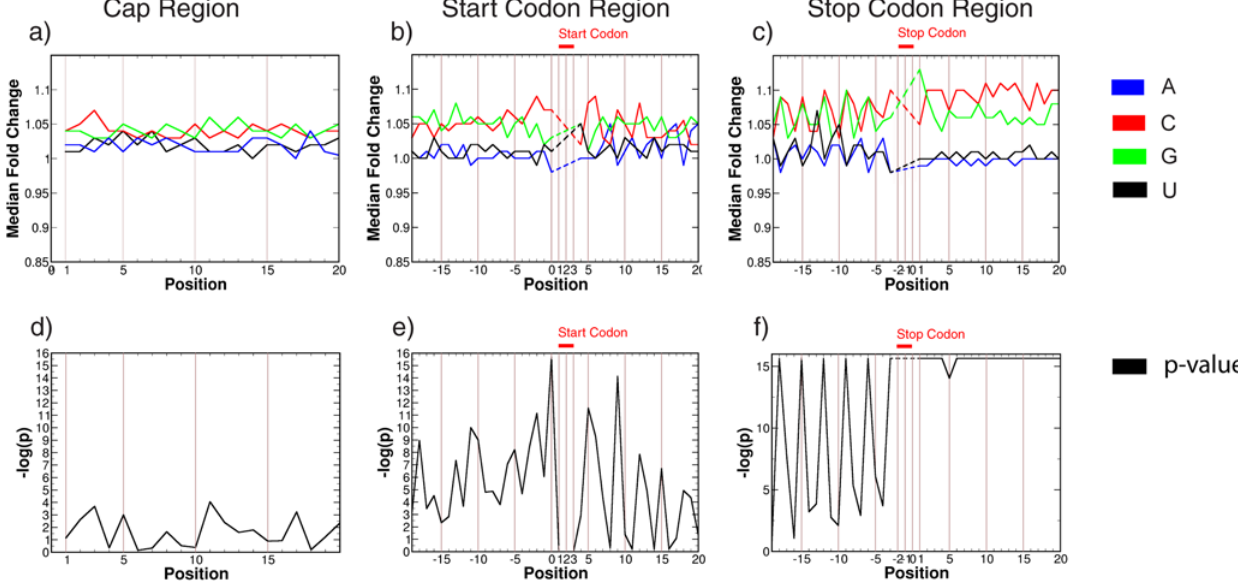
Figure 1. Sequence composition influences eIF4E responsiveness. Top row: median fold change of four groups of sequences corresponding to the four possible nucleotides at each position in the alignment around a) cap region (nt 1–20), b) start region (positions 2 19…20 with position 1 being the first nt of the coding region), c) stop region (positions 2 19…20 with position 1 being the first nt of the 3 9 UTR). Blue: A, red: C, green: G, black: U. Bottom row: Negative decadic logarithm of the Kruskal-Wallis test p-value as a function of the sequence position. The statistical test is applied at each alignment column to the fold change values of the four groups mention above. Note that because the Kruskal-Wallis test is not defined for completely conserved alignment columns, the start and stop codon regions are skipped (Figures a)–c)). The eIF4E overexpression data set consisting of 11387 mRNAs was used to generate the plots (see Materials and Methods).